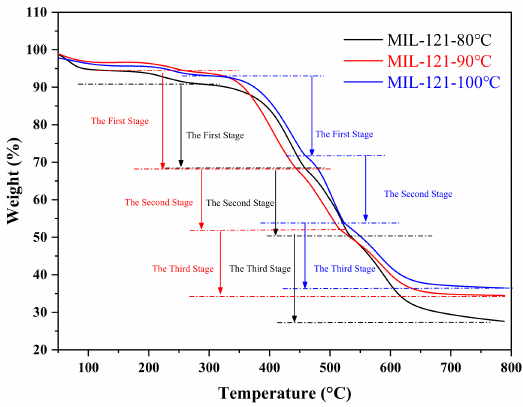
Figure 3. TG curves of MIL-121-80 ◦ C, MIL-121-90 ◦ C, MIL-121-100 ◦